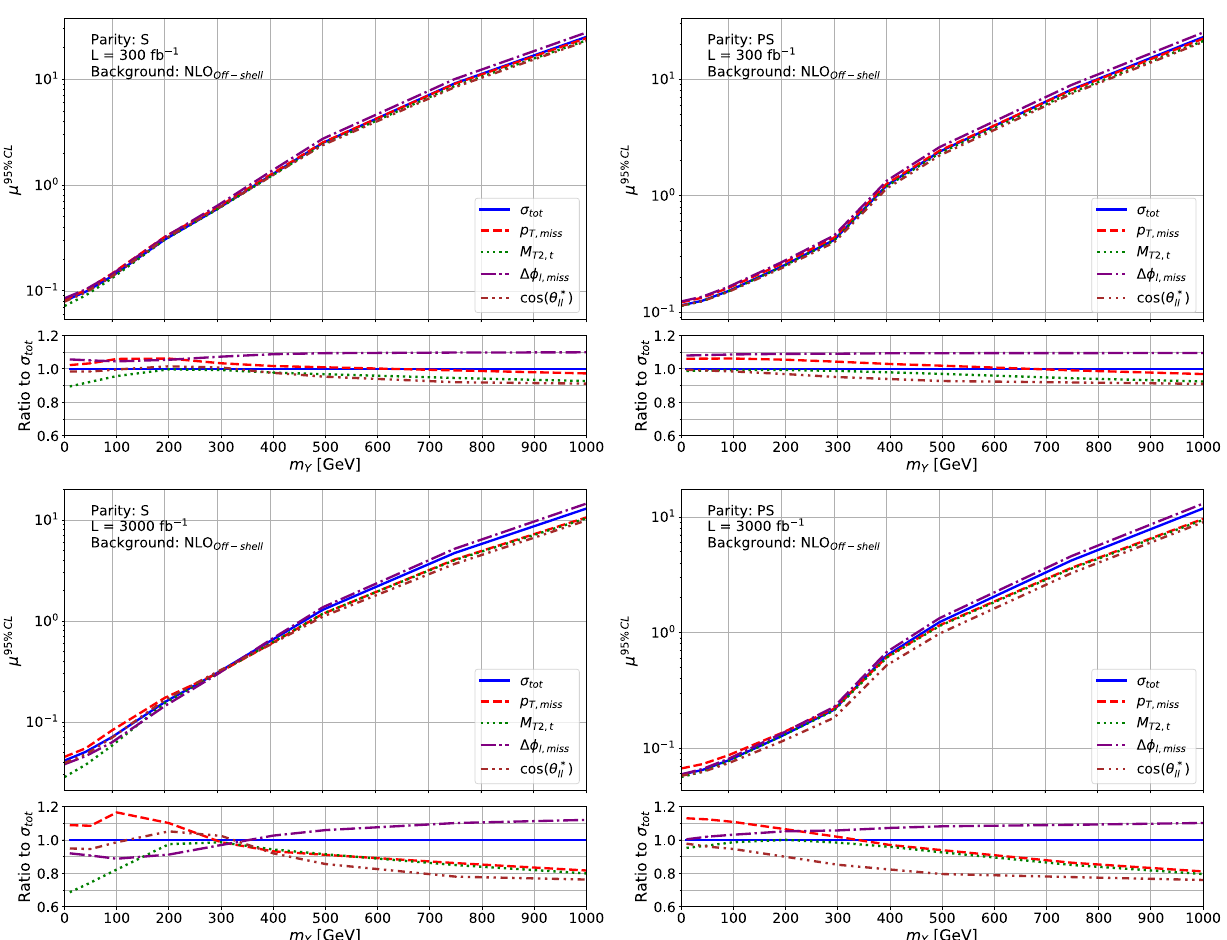
Fig. 14 Comparison of signal strength exclusion limits computed with different observables for the scalar (left) and pseudoscalar (right) medi- ator scenario assuming luminosities of L = 300 fb − 1 (first row) and